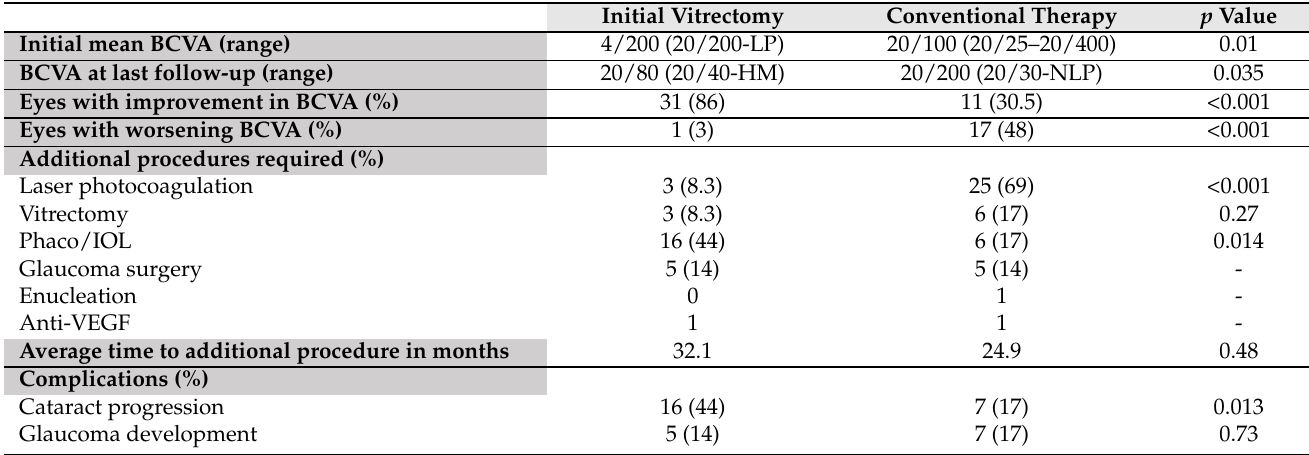
Table 3. Results, older than 50